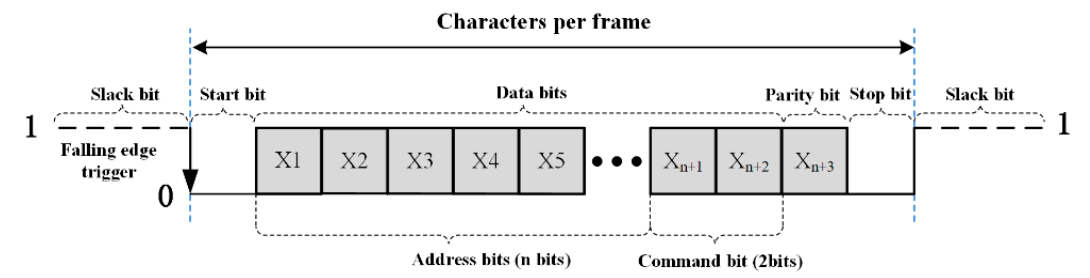
Figure 11. Communication protocol definition.